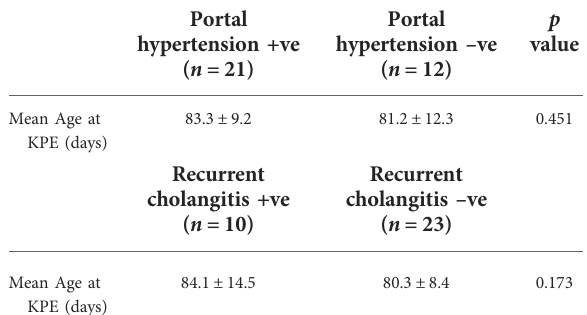
TABLE 2 The mean age at KPE for native liver survivors who suffered from portal hypertension and recurrent